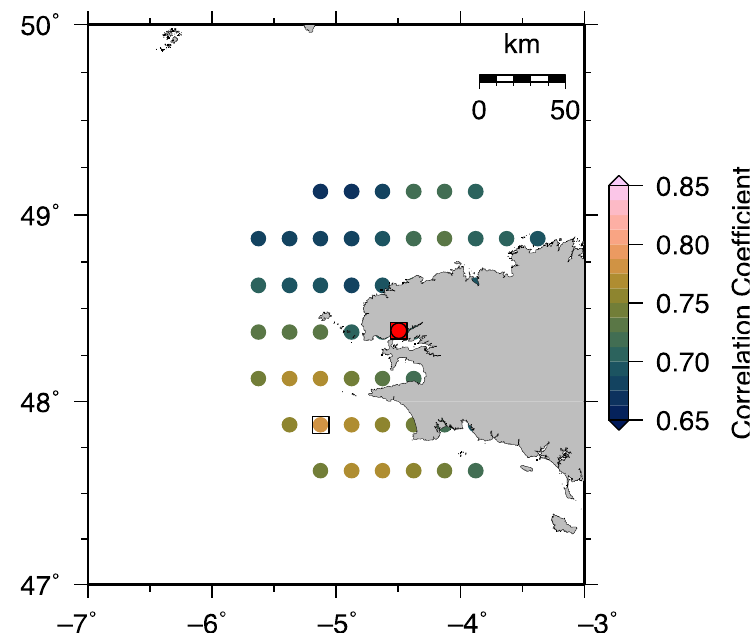
Figure A7. Correlation coefficient at SC02. The filled red circle represents the tide gauge while the open square represents the GNSS station. The colored dot with a black square is the grid point from which the de-seasoned and de-trended satellite altimeter data has the highest correlation coefficient with those from the coastal GNSS.